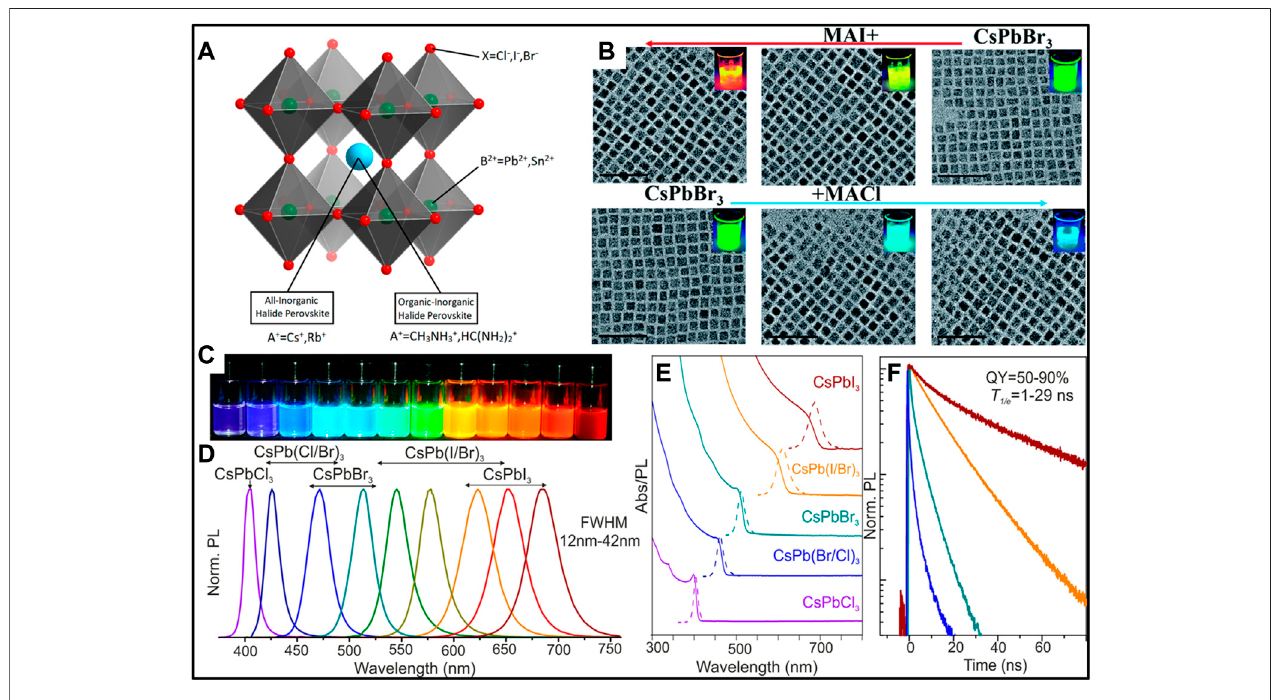
FIGURE 11 | (A) Structure of perovskite. (B) TEM image, (C) photo, (D) photoluminescence spectra, (E) absorption spectra, and (F) time-resolved photoluminescence of perovskite quantum dots (Protesescu et al., 2015).